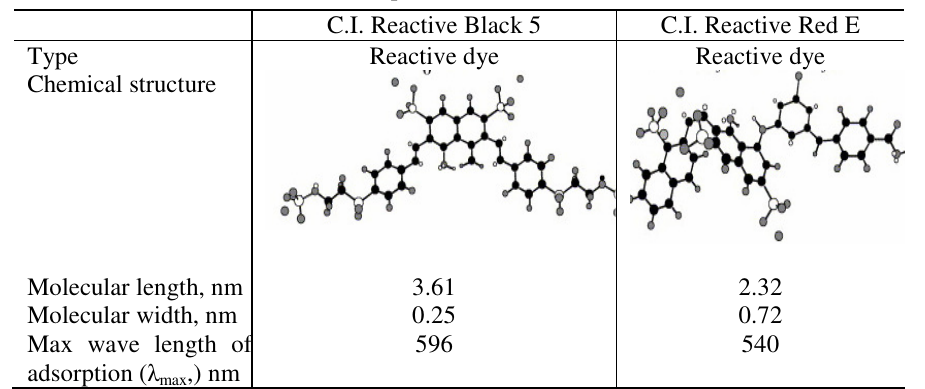
Table 1. Properties of RB 5 and RR E 9